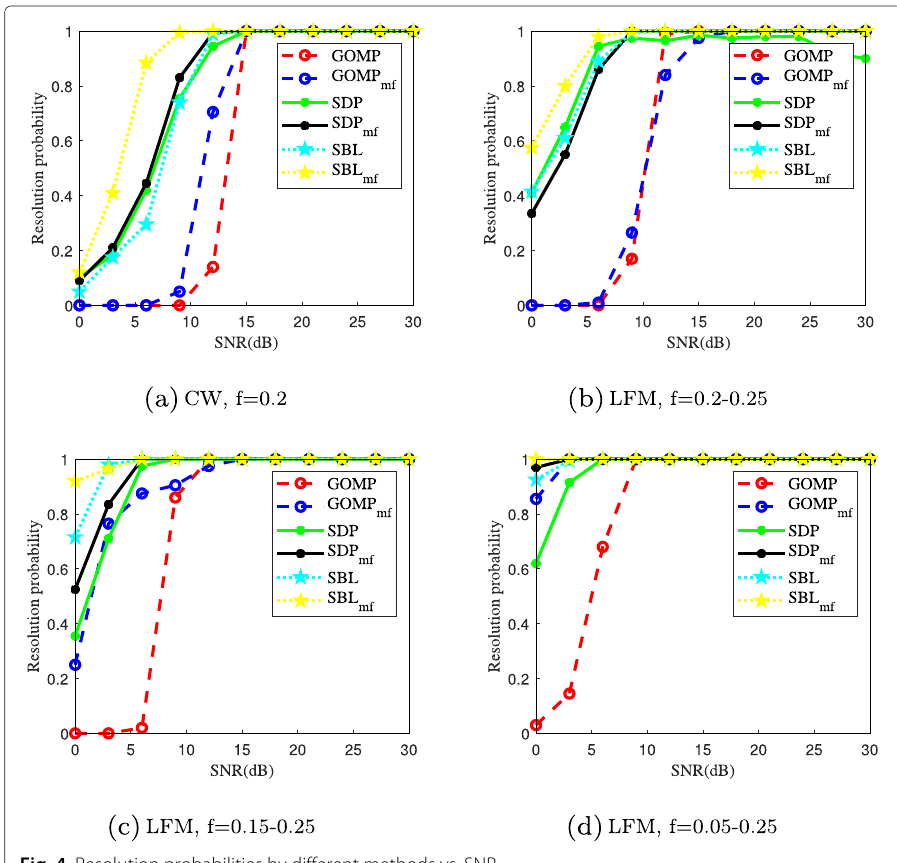
Fig. 4 Resolution probabilities by different methods vs. SNR